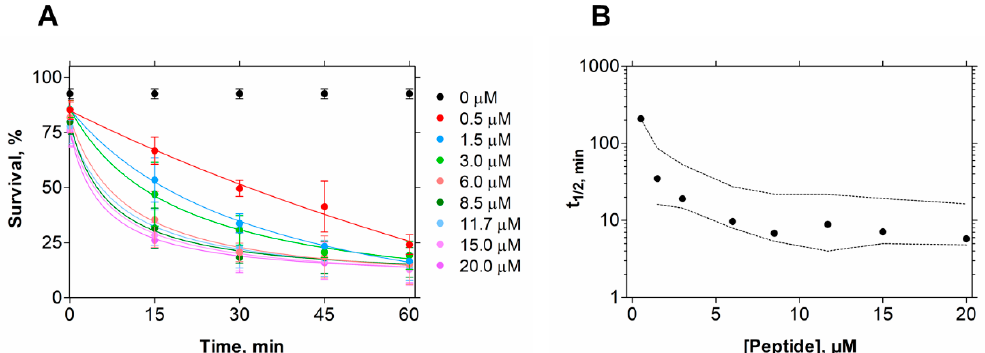
Figure 1. E. coli cell viability kinetics after EcDBS1R4 treatment. ( A ) Bacteria cell viability followed for 1 h by flow cytometry as a function of peptide concentration. ( B ) Time kinetics of cell viability after peptide treatment. Each point represents the time necessary to produce 50% of death for each concentration tested. Dashed lines indicate 95% confidence intervals .